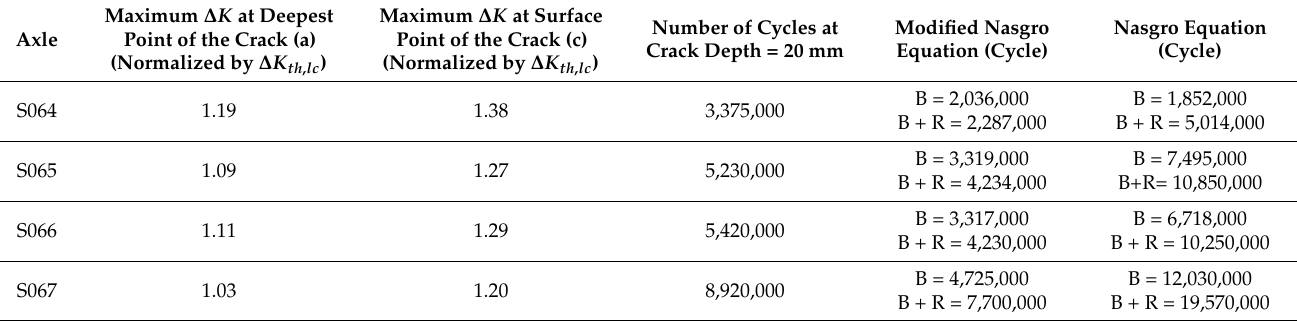
Table 4. Summary of full-scale axle crack propagation tests and life predictions (B = rotating Bending stress, R = Residual stresses including press-fit stresses and compressive manufacturing induced stresses). Maximum ∆ K at Deepest Point of the Crack